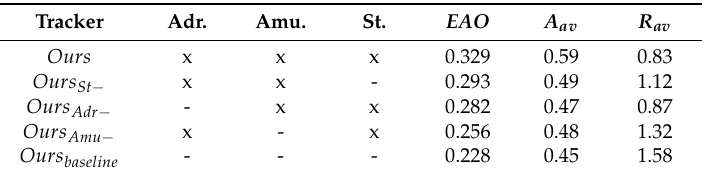
Table 1. Ablation study of the proposed method. The use of adaptive dimensionality reduction is indicated in the Adr. column and the use of the adaptive model updating is in the Amu. column. The St. column indicates whether to employ Siamese tracker.